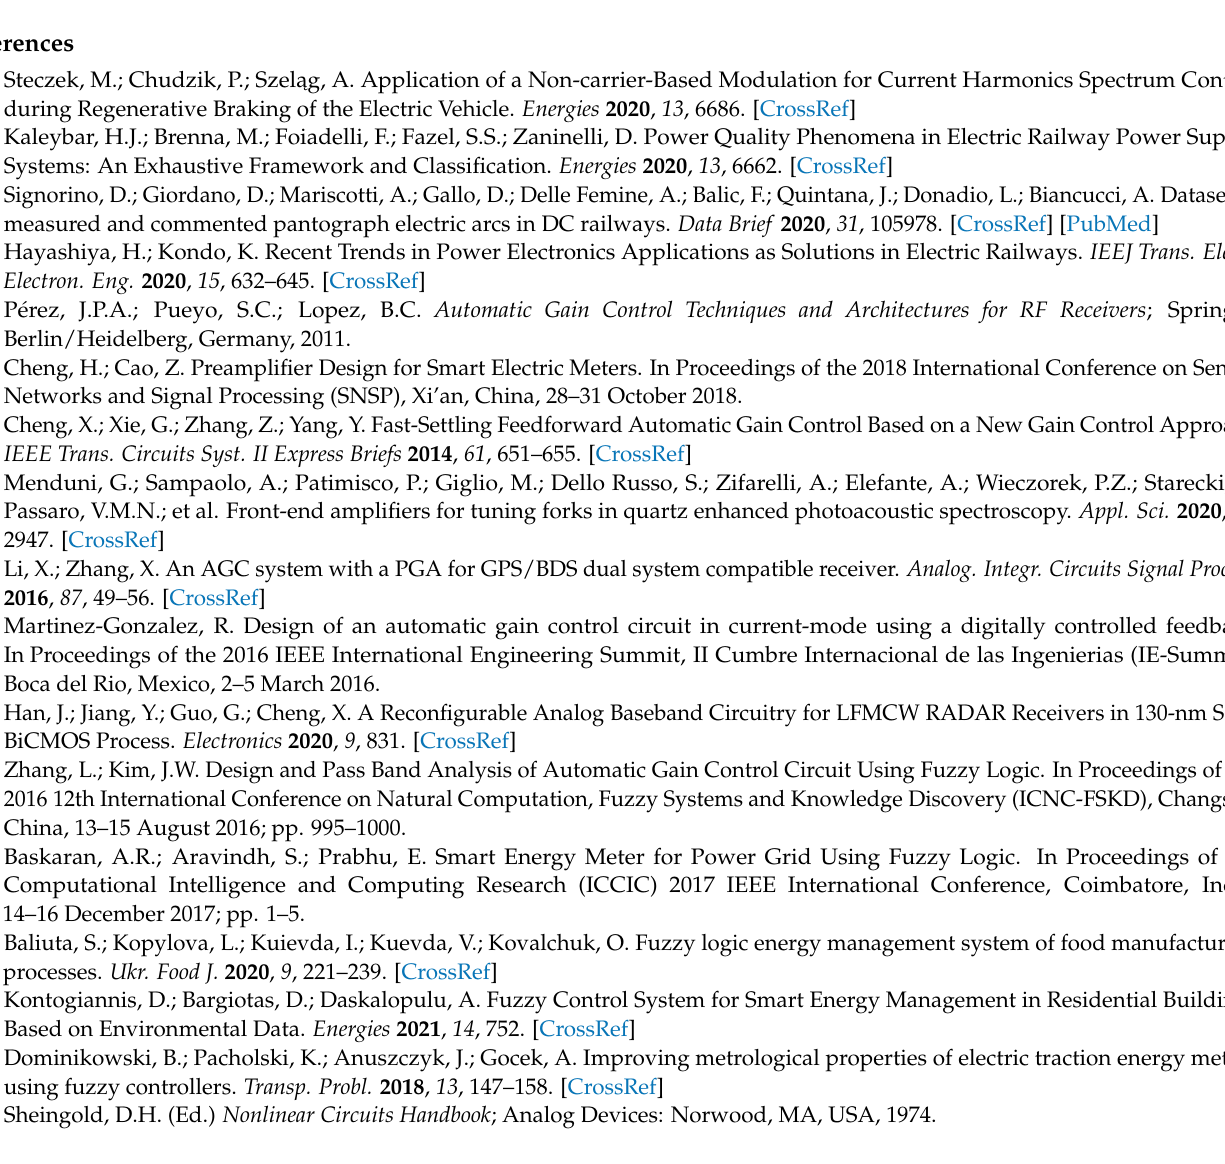
Figure A1. Workbench of AGC circuit (see Figure 4).